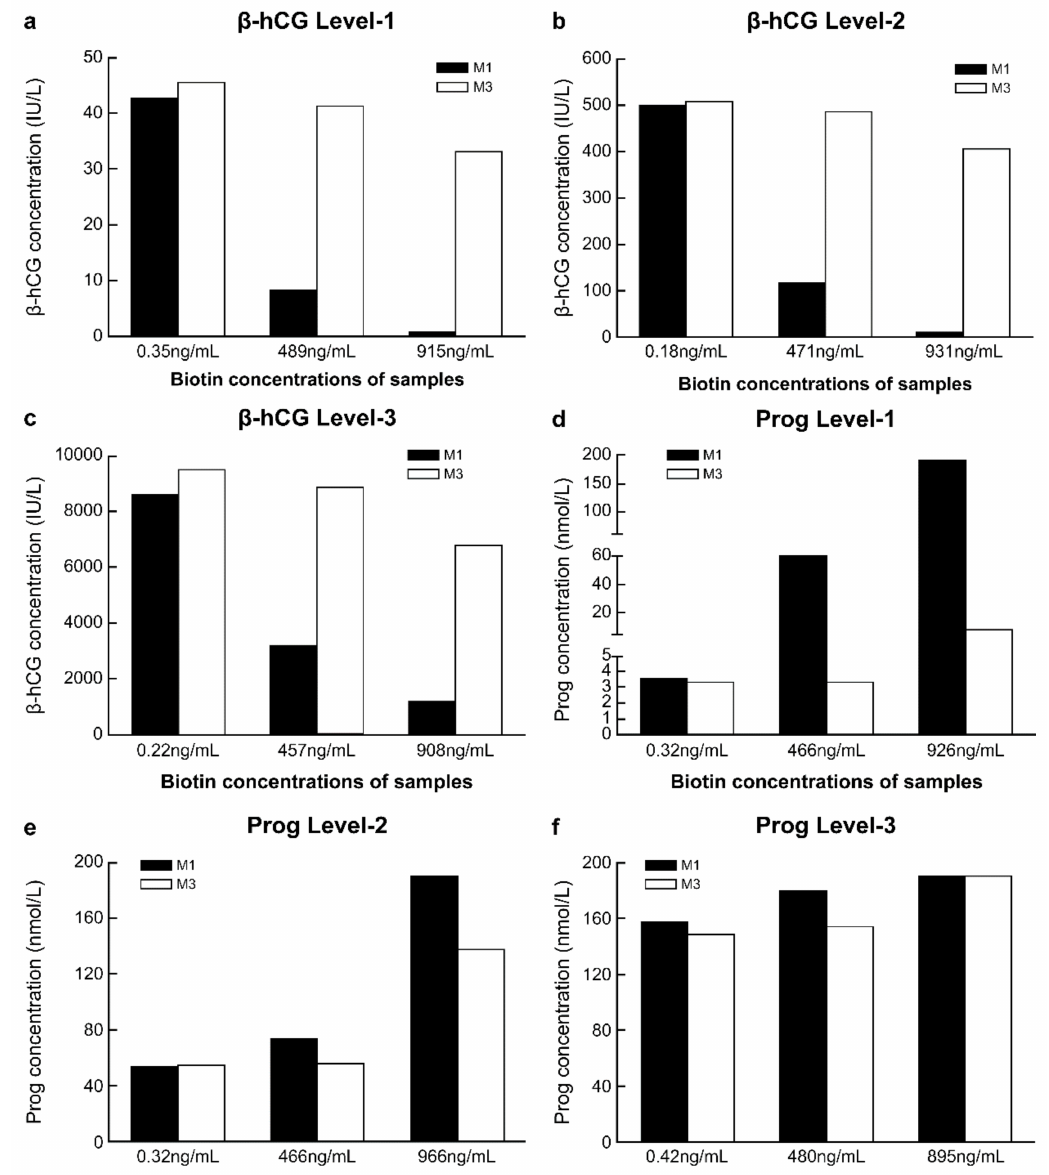
Figure 4. Comparison of the anti-biotin interference ability of M1 and M3. ( a ) Level-1 of β -human chorionic gonadotropin ( β -hCG), with a concentration of 42.62 IU/L; ( b ) Level-2 of β -hCG, with a concentration of 499.4 IU/L; ( c ) Level-3 of β -hCG, with a concentration of 8566 IU/L; ( d ) Level-1 of progesterone (Prog), with a concentration of 3.55 nmol/L; ( e ) Level-2 of Prog, with a concentration of 54.05 nmol/L; ( f ) Level-3 of Prog, with a concentration of 157.5 nmol/L. M1, 0.72 mg/mL streptavidin- coated magnetic microparticles. M3, 2.16 mg/mL streptavidin-coated magnetic